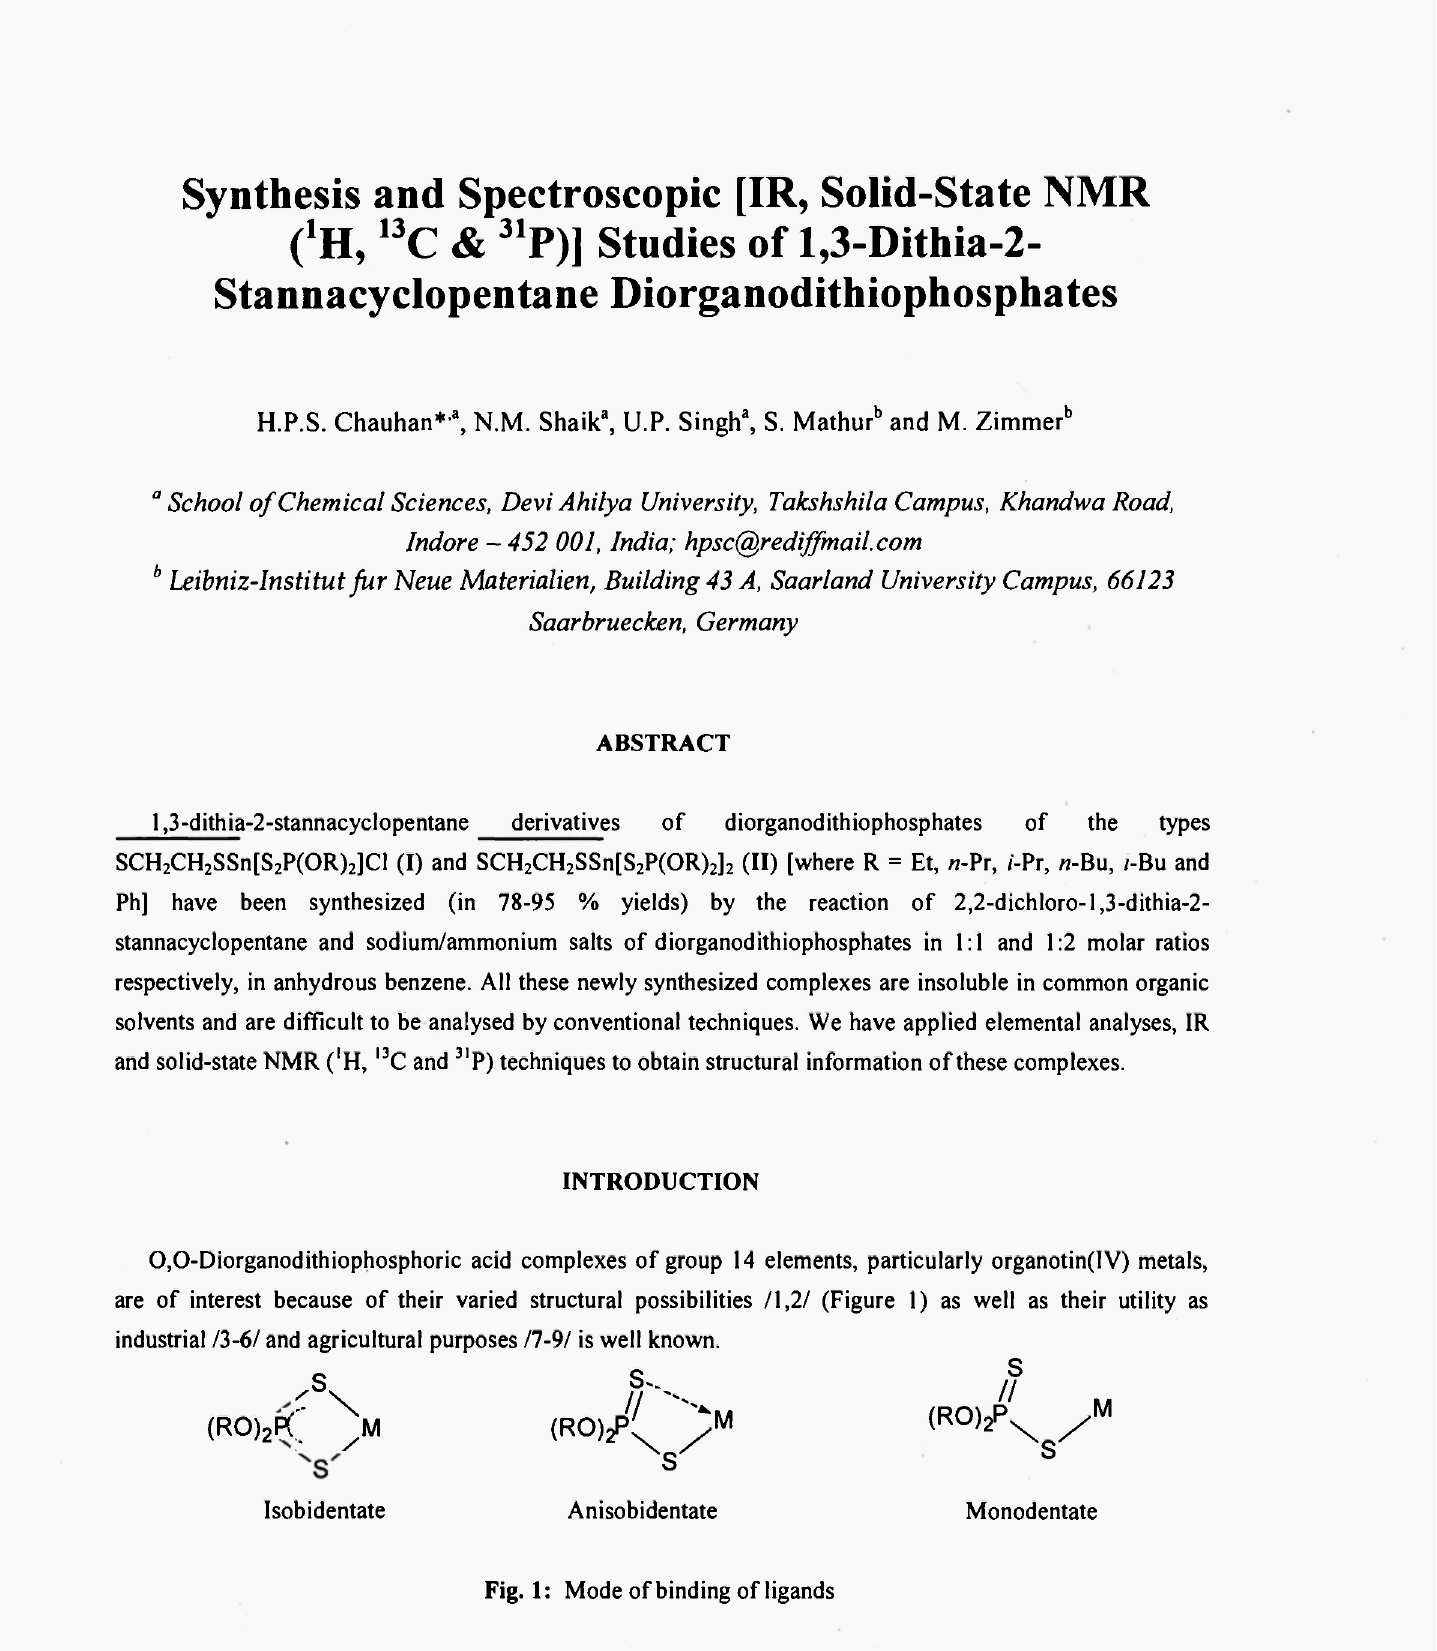
Fig. 1: Mode of binding of